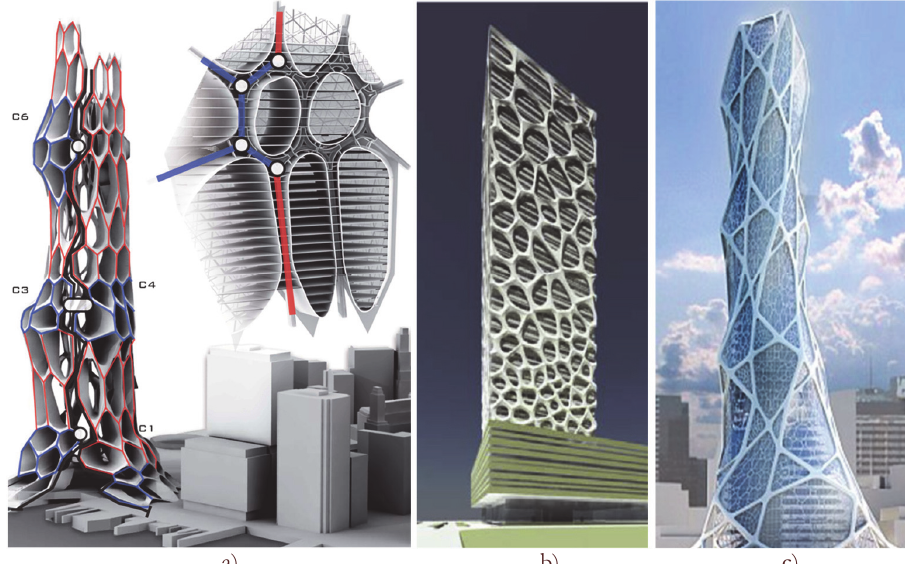
Figure 2: Voronoi patterns for tall buildings: a) “Use Arrangement” Christian Hahn eVolo 2010 Skyscraper competition entry; b) SOM competition entry for a tower in Tianjin; c) Lava Bionic